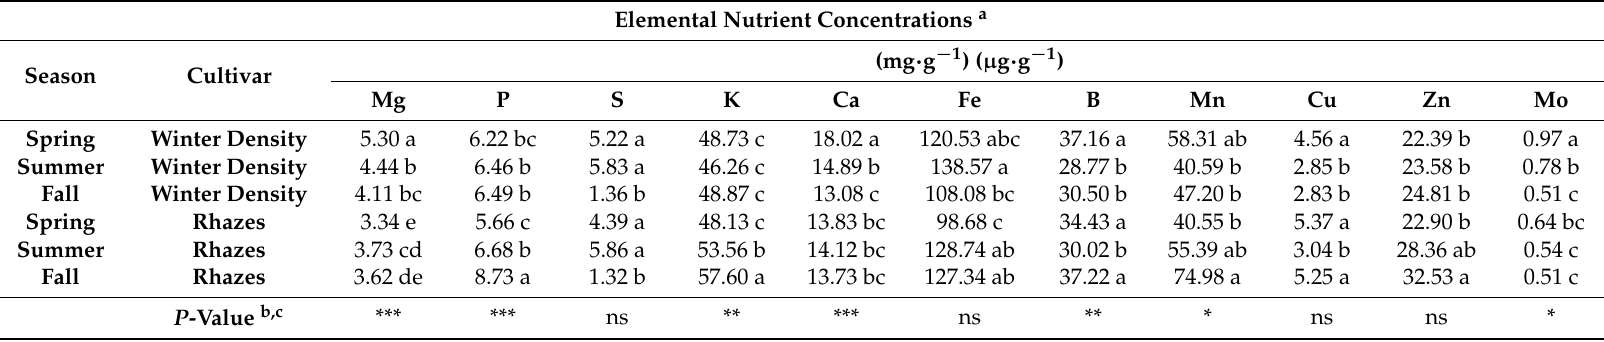
Table 4. The effect of season and cultivar on the concentrations of elemental nutrients in freeze-dried greenhouse lettuce leaf tissue.